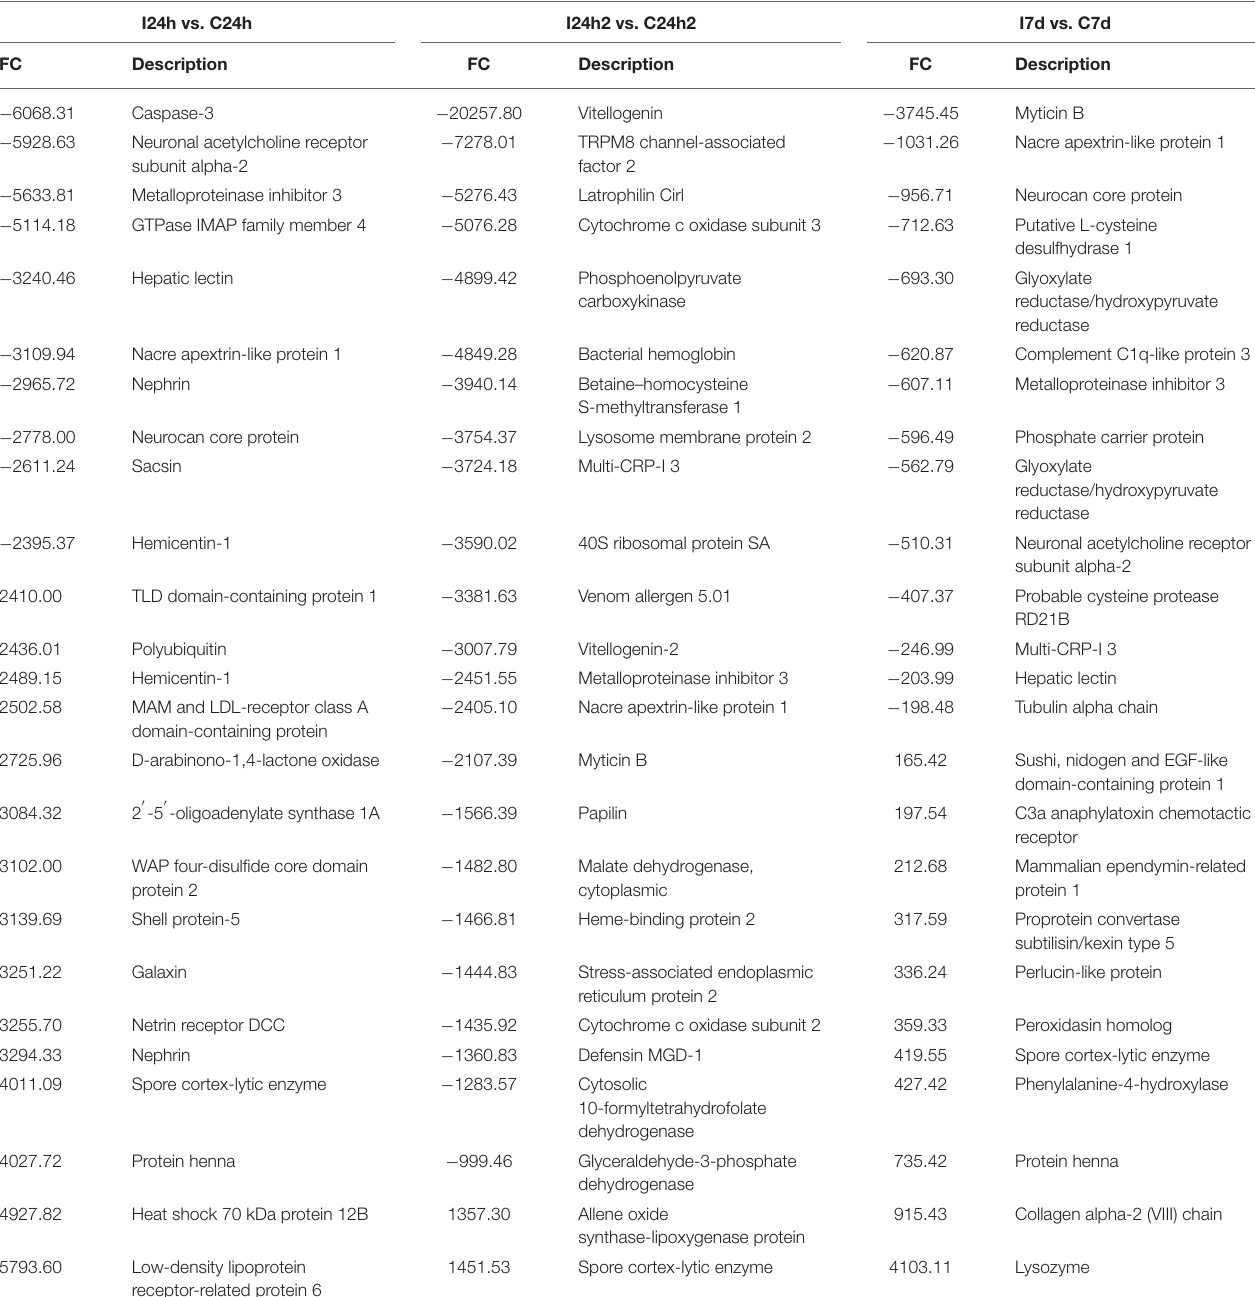
TABLE 2 | Top 25 DEGs at each sampling point. FC, fold